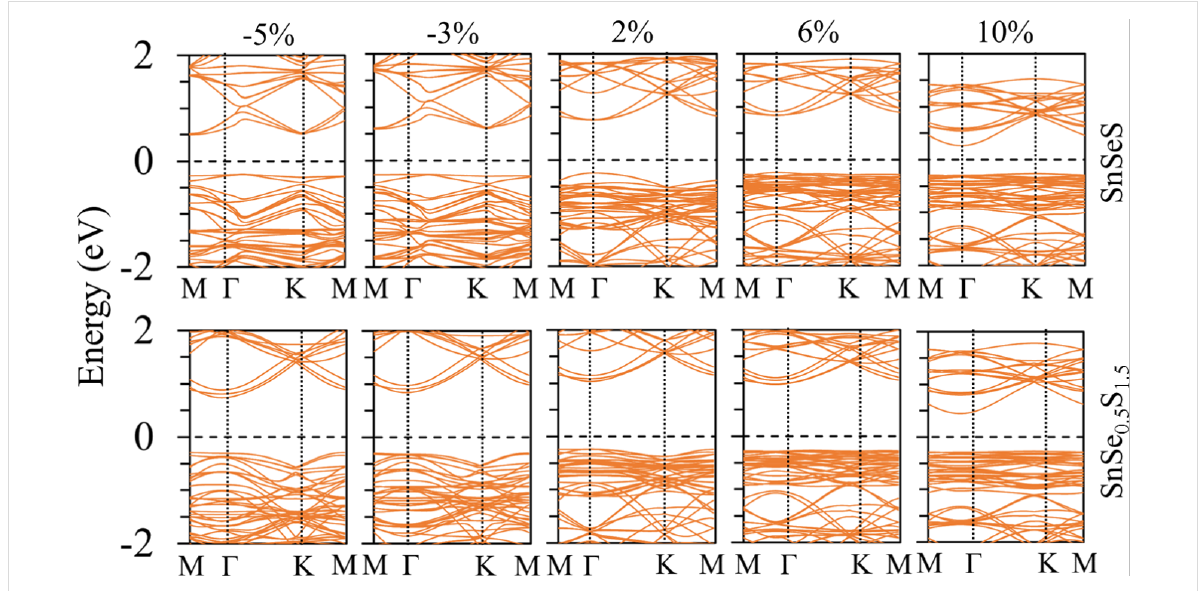
Figure 5: Band structures for SnSeS and SnSe 0.5 S 1.5 monolayers with strain of − 5%, − 3%, 2%, 6% and 10%.